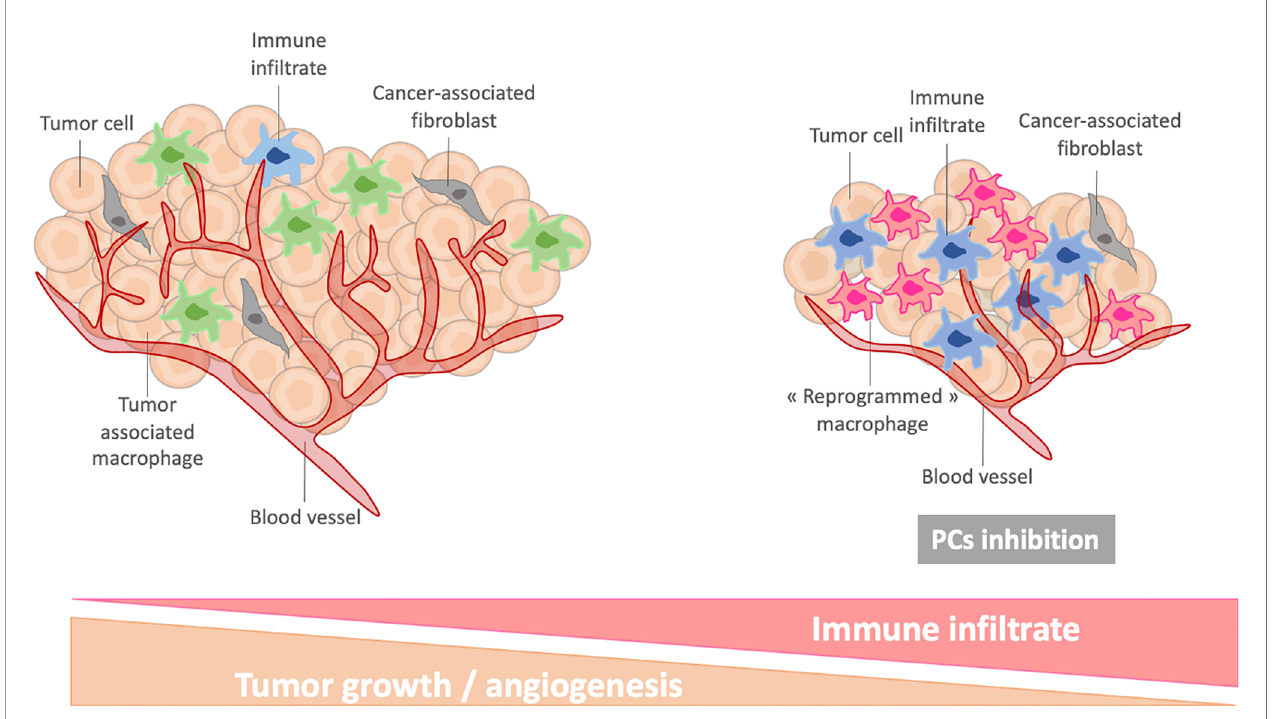
FIGURE 5 | Schematic representation of reprogrammed macrophages after PC inhibition in tumor